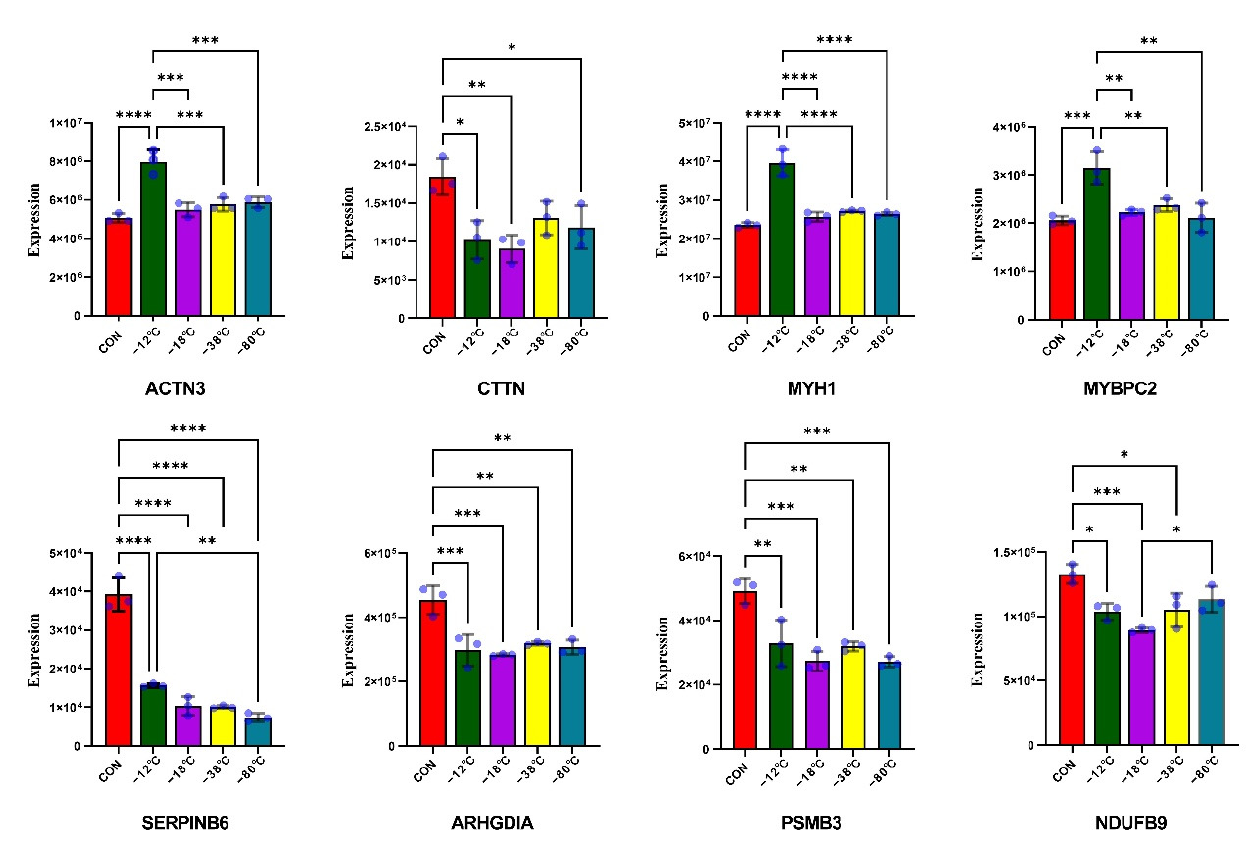
Figure 5. Expression profiles of the proteins in different freezing temperatures were validated by parallel reaction monitoring (PRM). The results were represented as mean ± SD from three experiments. Asterisks represent levels of significance (* p < 0.05; ** p < 0.01; *** p < 0.001; **** p < 0.0001).